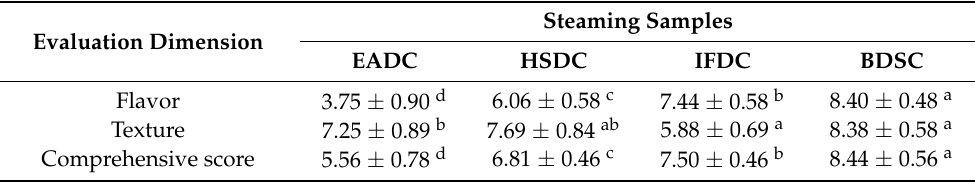
Table 1. Sensory rating scores for steaming sea bass obtained using different slaughter methods.